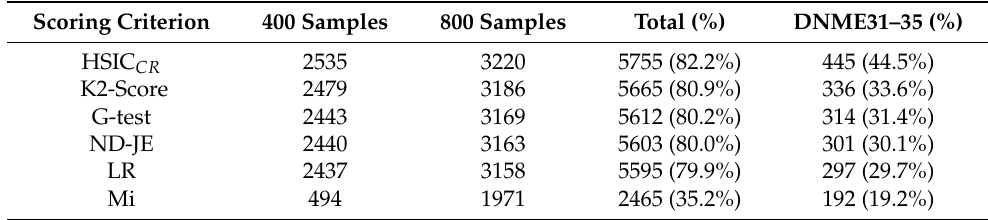
Table 1. The number of times, out of 3500 data sets generated by 35 models without marginal effects, where k = 2, that each scoring criterion identified epistasis SNPs of snp1000 for sample sizes of 400 and 800. The fourth column gives the total accuracy over all sample sizes. The last column gives the accuracy over all sample sizes in the most difficult subgroup models. The scoring criteria are listed in descending order of total accuracy.